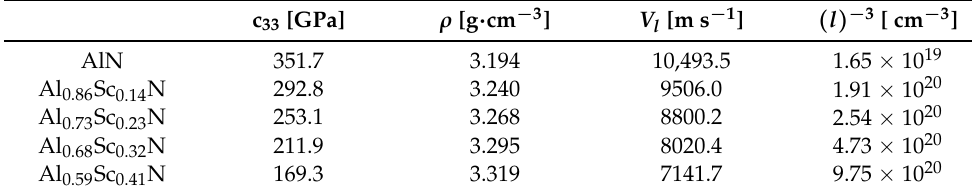
Figure 4. ( a ) Raman spectra of AlScN films at the low frequency spectral region. The spectra are stacked for clarity. The spectral bands are labelled by the positions of their maxima. The asterisk marks the band related to the Al 2 O 3 substrate. ( b ) The positions of the low-frequency bands plotted as a function of the Sc concentration. The dashed lines are the linear fits. Table 2. Material properties of the AlScN pseudobinary alloys, such as the elastic constant, c 33 , and the mass density, ρ [54] necessary to estimate the longitudinal sound velocity, V l , and the point defect density, ( l ) − 3 . The mode position and linewidth are taken from Table